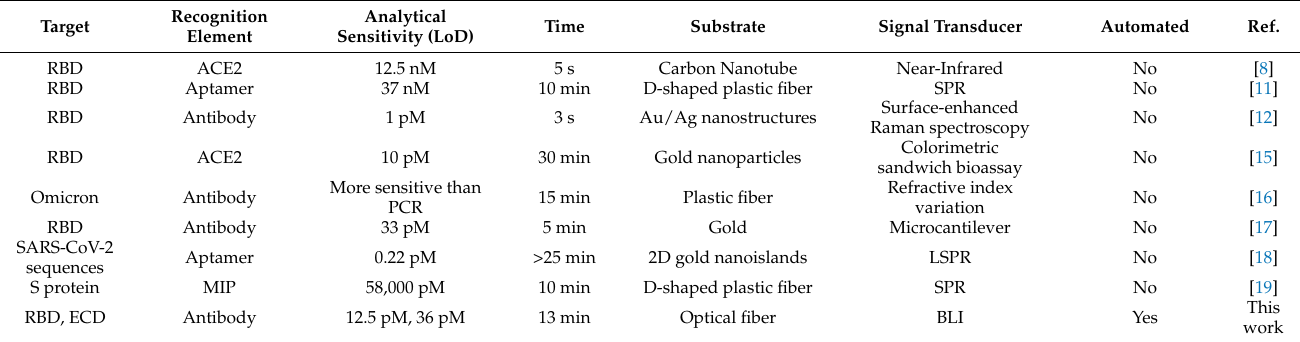
Table 2. Comparison of performance of the optical biosensors reported in literature and this work for SARS-CoV-2